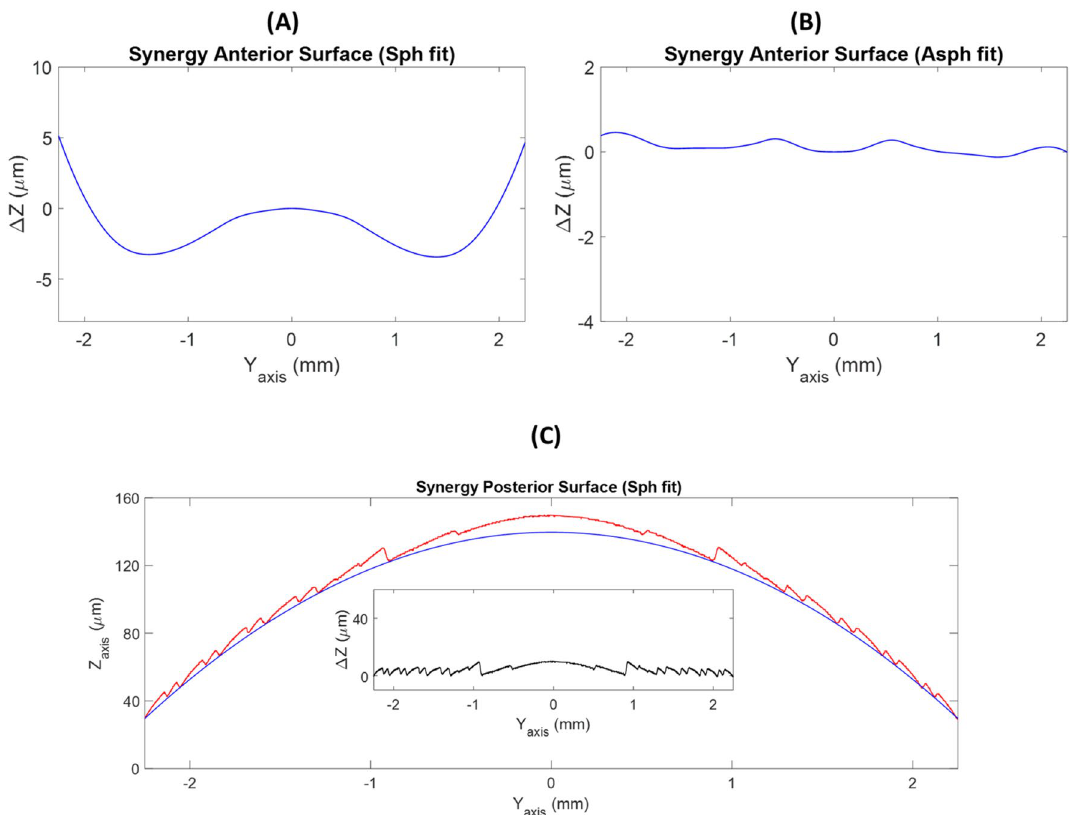
Figure 7. Subtraction lines obtained after the removal of the best-fit sphere ( A ) or asphere ( B ) from the smooth profiles of the anterior surface of the Synergy IOL. ( C ) Diffractive design of second surface and best-fit sphere for the echelette profile of the second surface of the Synergy IOL. The inset showed differences between complete profile and base curve